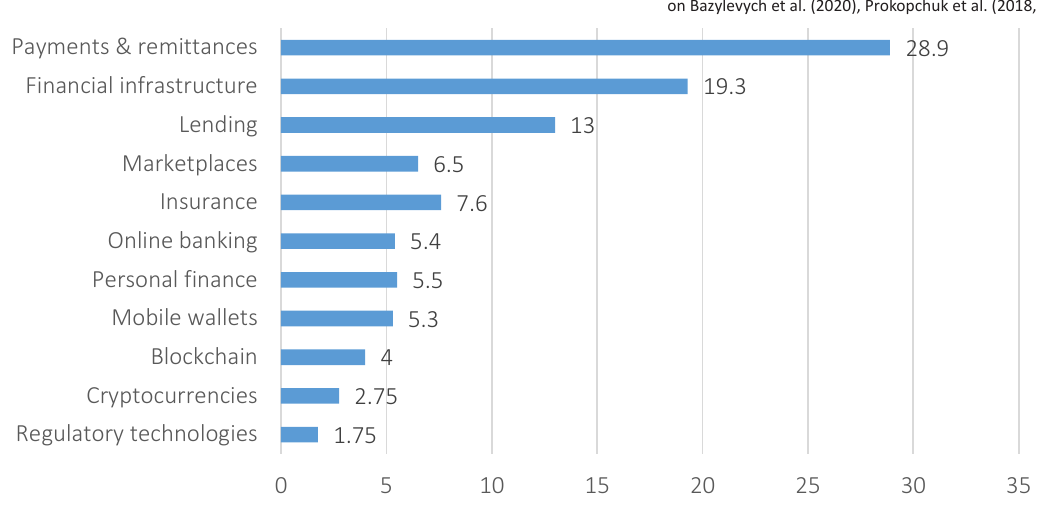
Figure 11. The structure of functioning of FinTech products in Ukraine in 2021,